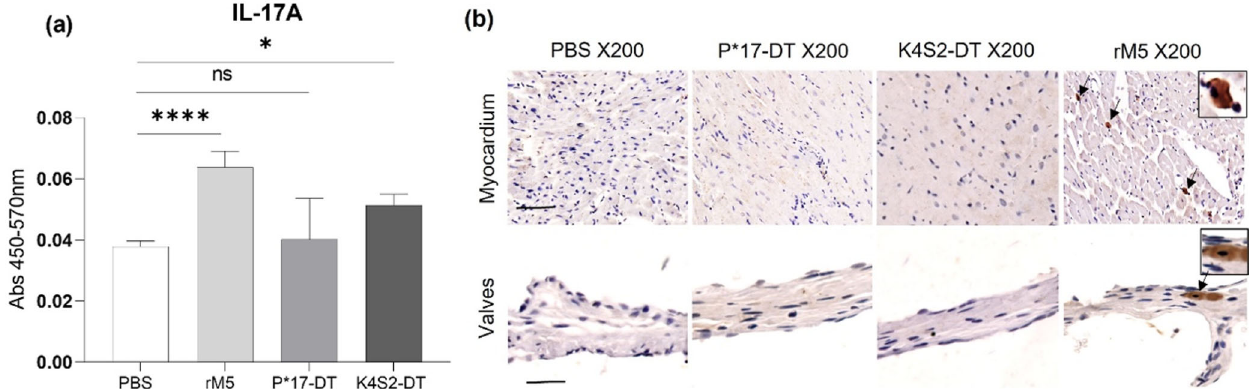
Fig. 5 Systemic and localised presence of IL-17A. Detection of pro-in fl ammatory IL-17A in the sera and cardiac tissues of rats injected with PBS, rM5, P*17-DT or K4S2-DT. IL-17A in sera was assessed by ELISA ( a ). Absorbance values at day-35 are shown. Statistical analysis performed by one-way ANOVA with multiple comparison test. Signi fi cance to PBS control group, *P < 0.05 and **** P < 0.0001. Error bars represent standard deviation. Tissue-speci fi c localisation of IL-17A in the myocardium and valvular tissues of rats was investigated by immunohistochemical staining ( b ). Representative images from two rats in each group given ( b , S1). Images magni fi ed at ×200, snippets magni fi ed at ×400, and scale bar represents 50